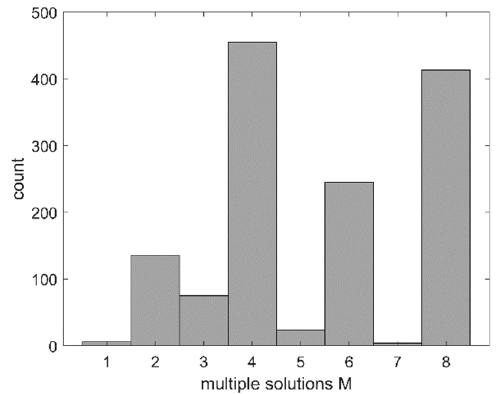
Figure 5. Histogram of the number of multiple solutions, M ( j ) , provided by the AIK for each robot pose.